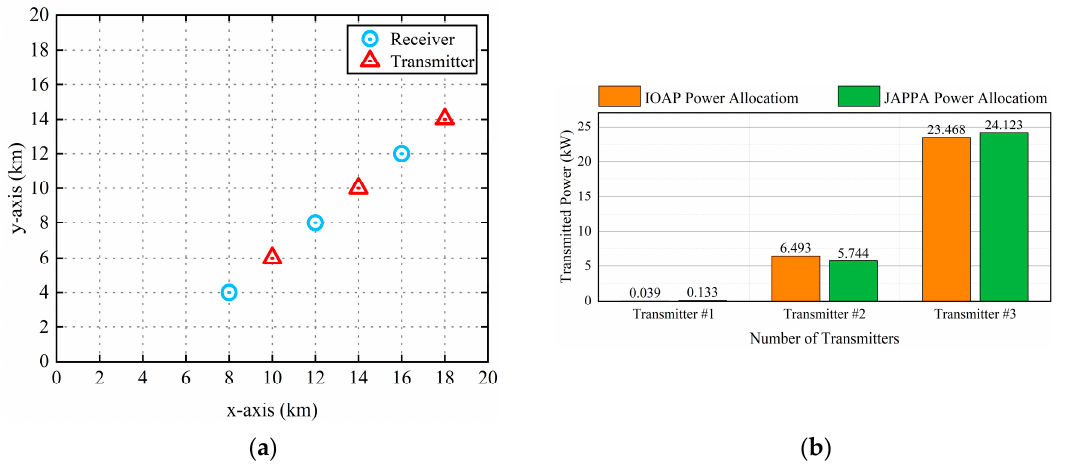
Figure 9. Optimal scheme based on IOAP. ( a ) IOAP Antennas’ geometry distribution; ( b ) IOAP power assigned to the transmitters.